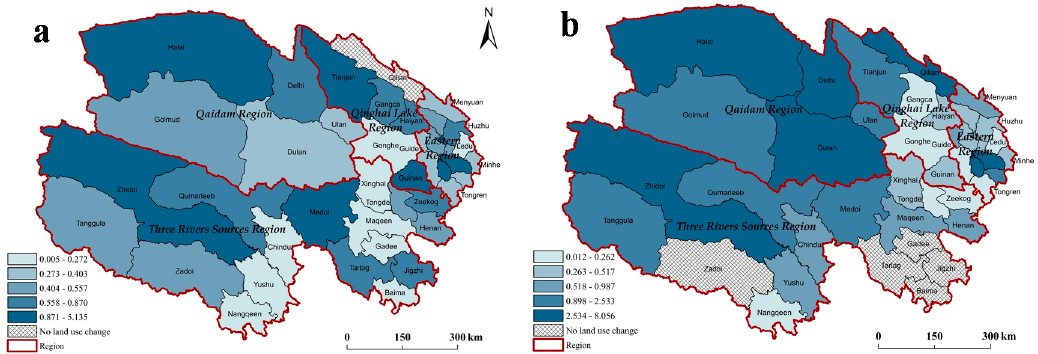
Figure 5. Sensitivity of ecological service value in Qinghai Province in ( a ) 1988–2000 and ( b ) 2000–2008. Spatially, the sensitivity was higher in the northern part in Qaidam region (Haixi, Delhi and Tianjun), the Tanggula Mountains (Zhiduo, Tanggula Mountain Village, Qumarleeb and Zadoi) and the southeast of Qinghai Province (Maduo, Dari and Banma), but there was no great difference between counties. From 2000 to 2008, regional sensitivity was clearly divergent. The sensitivity was lower in the eastern area where human activities were frequent and increased gradually to the Three Rivers Source region and Qaidam region.